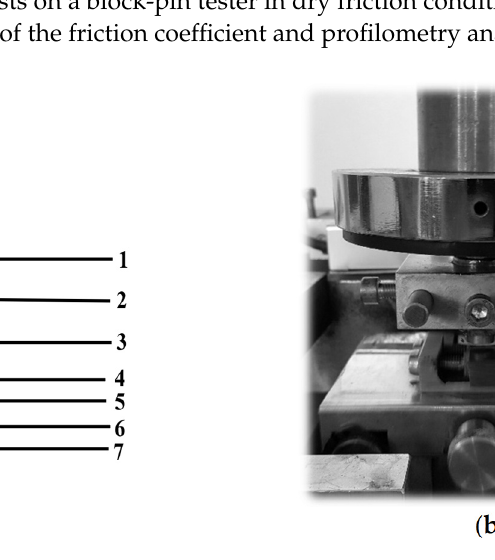
Figure 6. The experimental pin-on-block set-up used in tribological tests: ( a ) scheme of the stand, where: 1—Load, 2—strain gauge holder, 3—sample holder (pin), 4—cast iron pin, 5—sample holder (block), 6—composite sample, and 7—movable plate; and ( b ) view of the stand. Table 2. The parameters used in tribological tests.